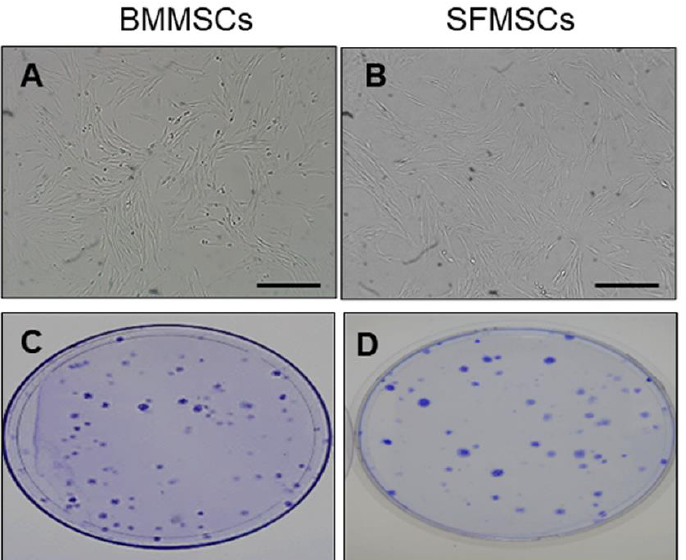
Figure 1. Morphology and colony forming unit (CFU) of MSCs from bone marrow and synovial fluid during cell culture. Representative microscopic images of MSCs from bone marrow ( A ) and synovial fluid ( B ) with approximately 80% confluence at 100 × magnification. ( C , D ) CFU assay of bone marrow and synovial fluid derived-MSCs, respectively, cultivated as 100 cells per 100 cm 2 culture dish for 7 days. The colonies stained with 0.5% crystal violet.